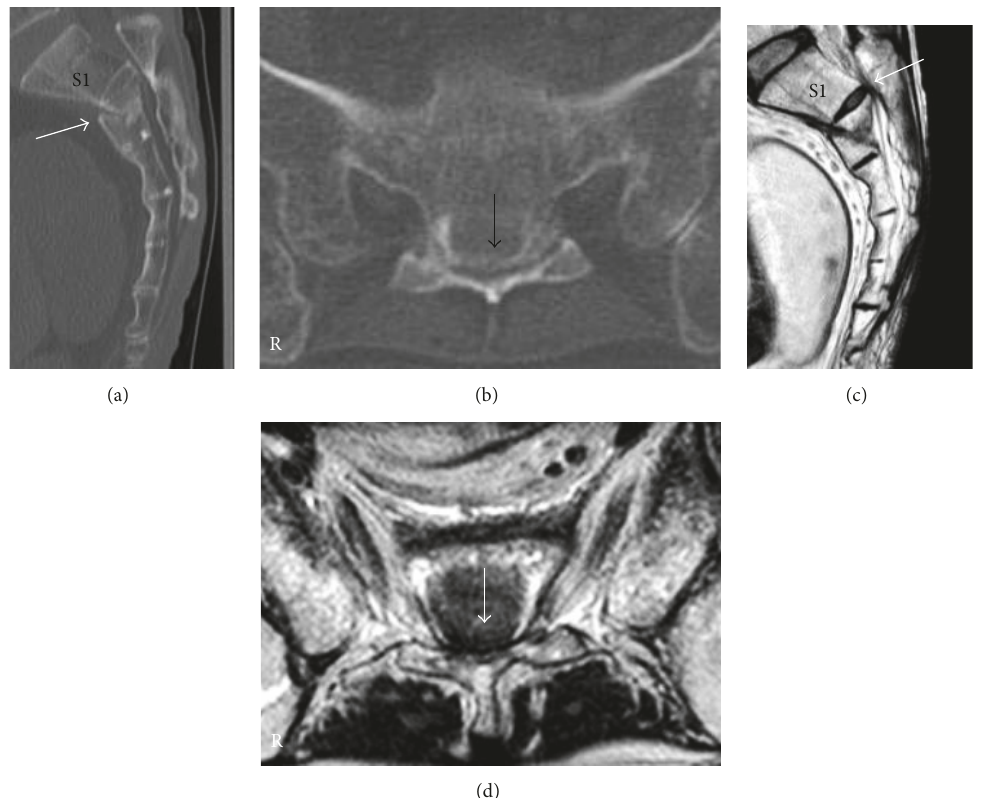
Figure 5: Reconstructed computed tomography (CT) and magnetic resonance image of sacrum at first hospital presentation . (a) Sagittal reconstructed CT image. (b) Axial CT image at S2 level. (c) Sagittal plane on a T2-weighted image. (d) Axial plane on a T2-weighted image. Displaced fractures in the second sacral vertebral body (white arrow) can be observed (a). This radiological finding was consistent with a Roy-Camille classification type II fracture [5]. Sacral canal was narrowed by the protruding sacral vertebral body (black arrow) (b). This radiological finding was diagnosed as a Denis Zone III sacral fracture [15]. Sagittal and axial planes on T2-weighted images showed that sacral nerves were compressed by the vertebral body (white arrow) (c, d).